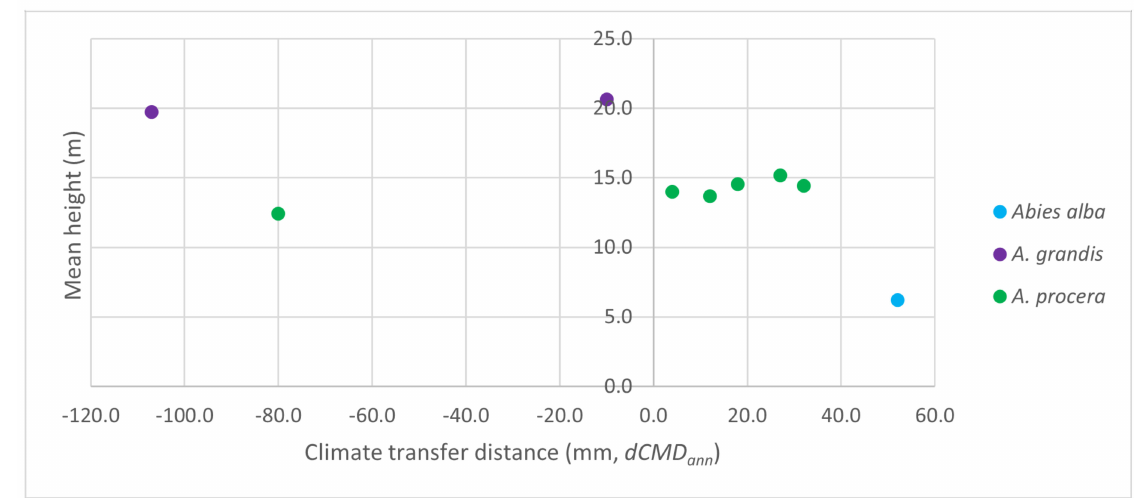
Figure 9. Mean height response of noble fir provenances to climate transfer distance (current vs past) expressed in annual climatic moisture deficit (mm precipitation deficit dCMD ann ), in the trial Dražiˇcky (see also Figure A3a,b for distances expressed in temperature and